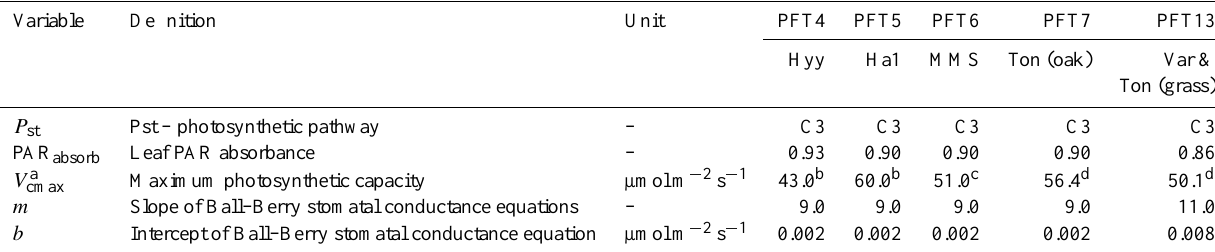
Table D1. Biophysics parameters for Fluxnet sites in this study.